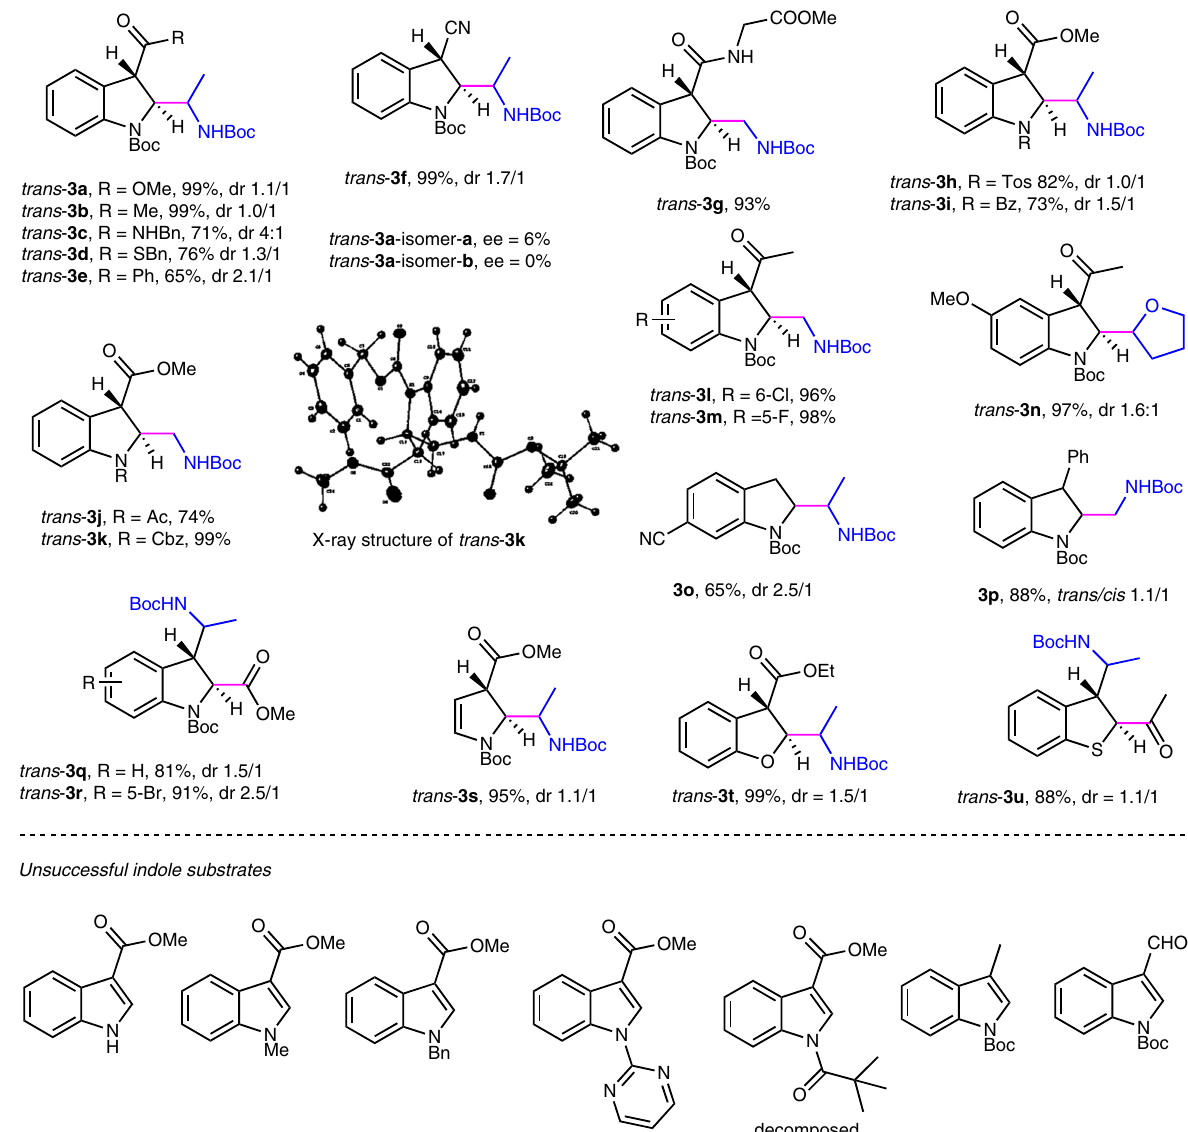
Fig. 2 Scope of indoles and other hetereoaromatics. Unless speci fi ed, see the general procedure in Supplementary Methods Section 1.5 for the experimental